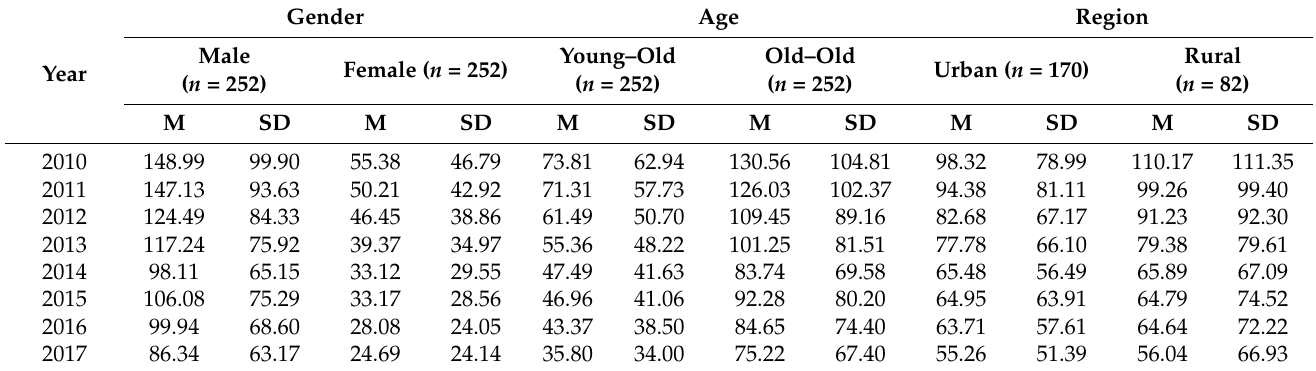
Table 1. Suicide rate of older adult by gender, age, and region